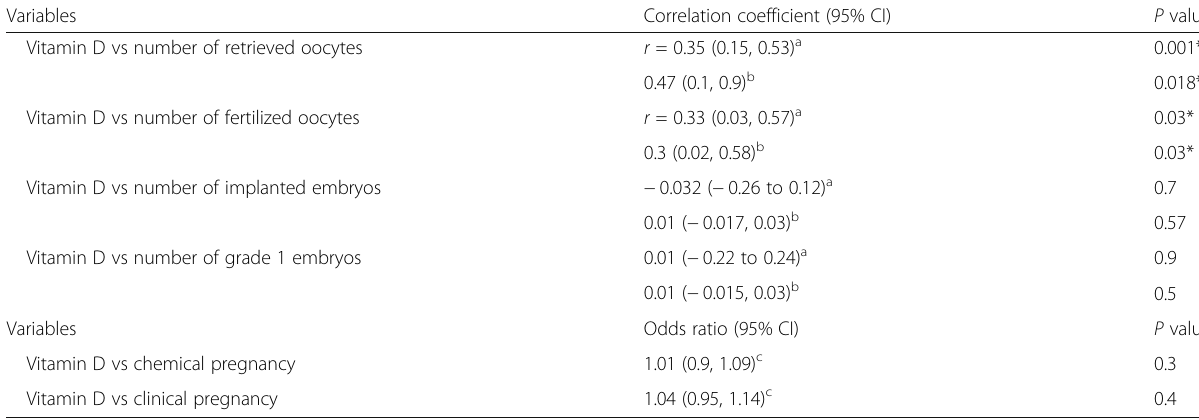
Table 4 Correlations between serum 25 (OH) vitamin D and the number of retrieved and fertilized oocytes, and other ICSI cycle outcomes